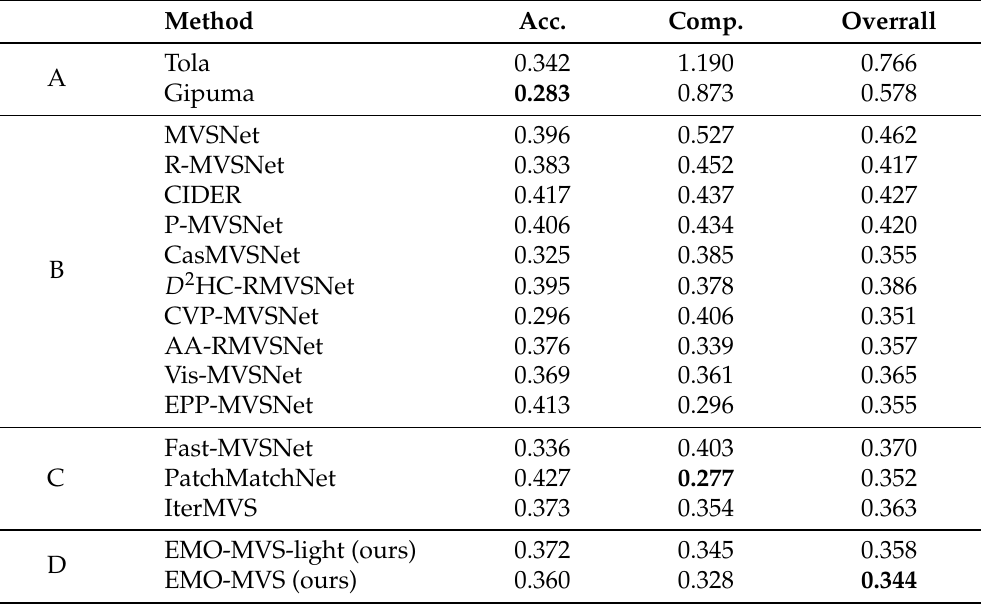
Table 1. Quantitative results of reconstruction quality on the DTU evaluation dataset ( ↓ ). A and B are the conventional methods and high-accuracy learning-based methods, respectively. C and D are high-efficiency learning-based methods. Bold font represents the best.